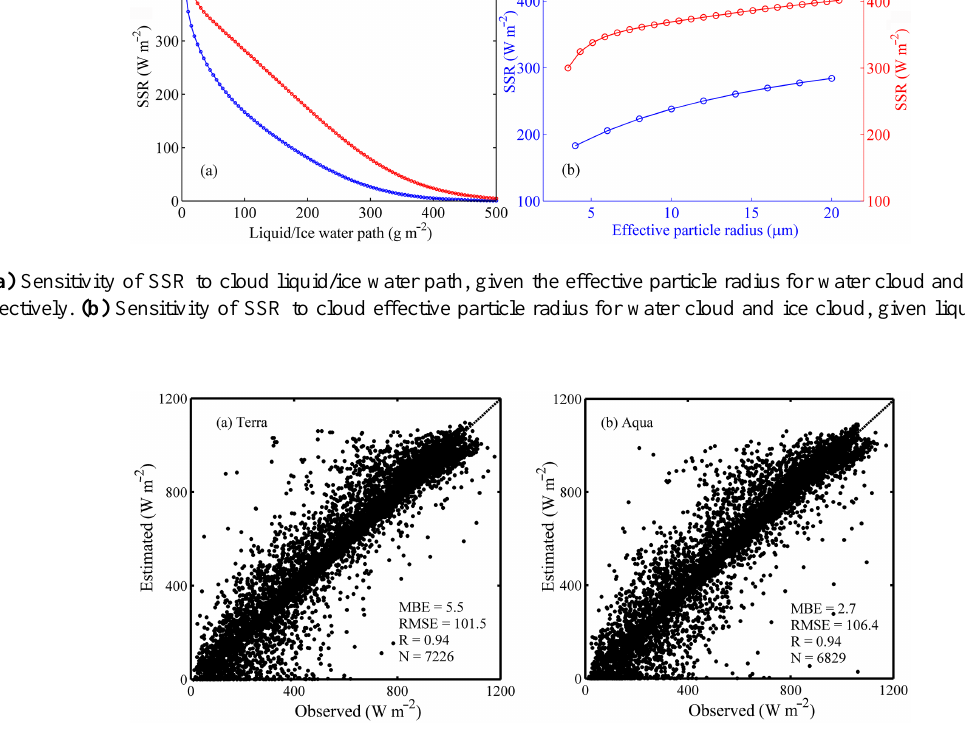
Figure 6. Validation of instantaneous SSR estimated with the MODIS atmospheric and land products against the observed ones at 44 BSRN stations in 2009 for (a) Terra and (b) Aqua platforms. Units of MBE and RMSE are Wm − 2